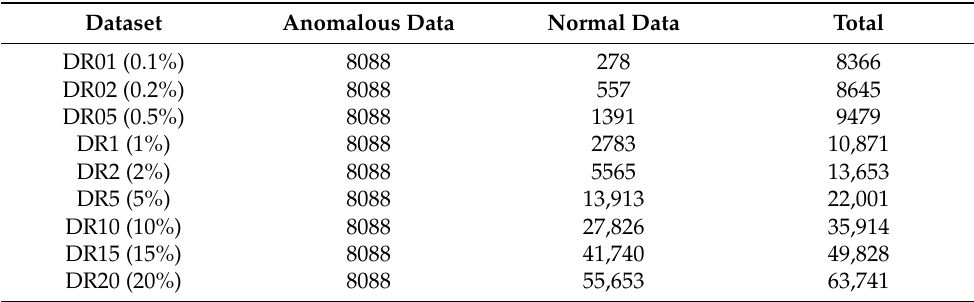
Table 2. Subsets of classes with anomalous data and percentage of samples from class ‘NL’ with normal data.